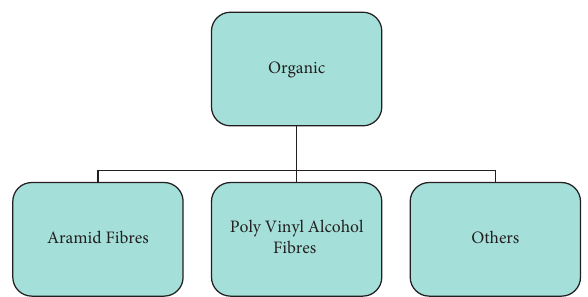
Figure 2: Organic structure of different types of fiber laminates.